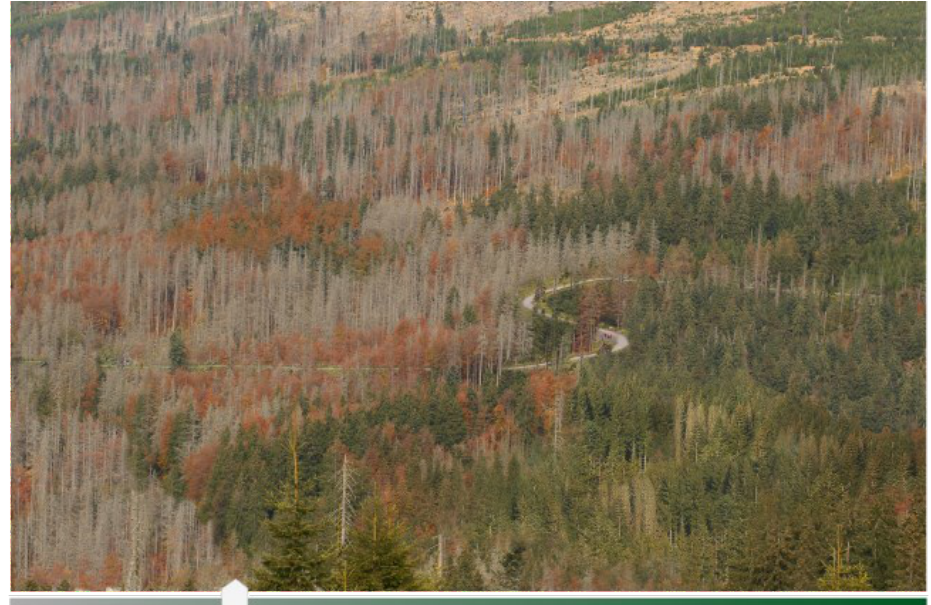
Figure 1. An artificial landscape depicting an outbreak of the European spruce bark beetle ( Ips typographus ). The landscape ranged from entirely killed (left side) to entirely intact (right side) forests. A hiking trail was inserted for visual purpose.